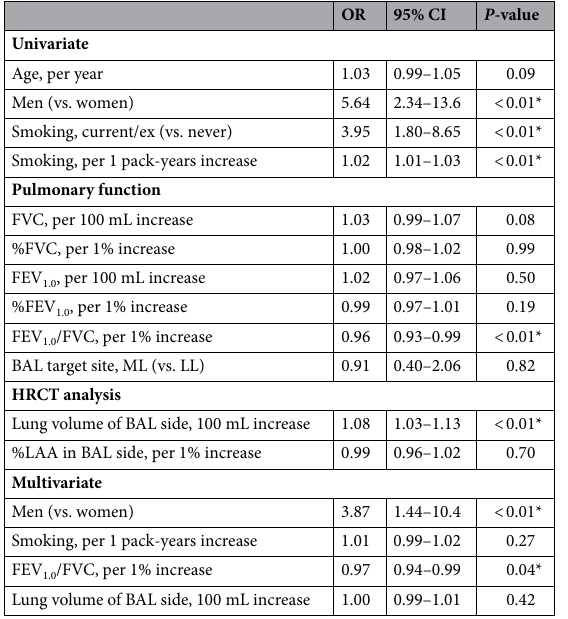
Table 4. Logistic regression analysis for BALF recovery failure in the RM/LL group. BAL bronchoalveolar lavage, BALF BAL fluid, OR odds ratio, CI confidence interval, FVC forced vital capacity, %FVC